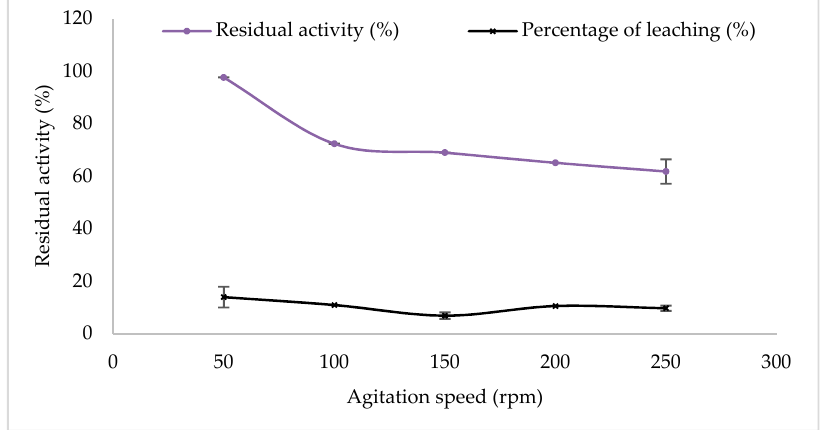
Figure 7. The residual activities of CRL/MgO-Al 2 O 3 after shaking at various agitation speeds for 60 min at 30 °C. The initial activity of CRL/MgO-Al 2 O 3 before being incubated at various ranges of agitation speed was set as 100%. The error bars represent the standard deviation of triplicate experiments.